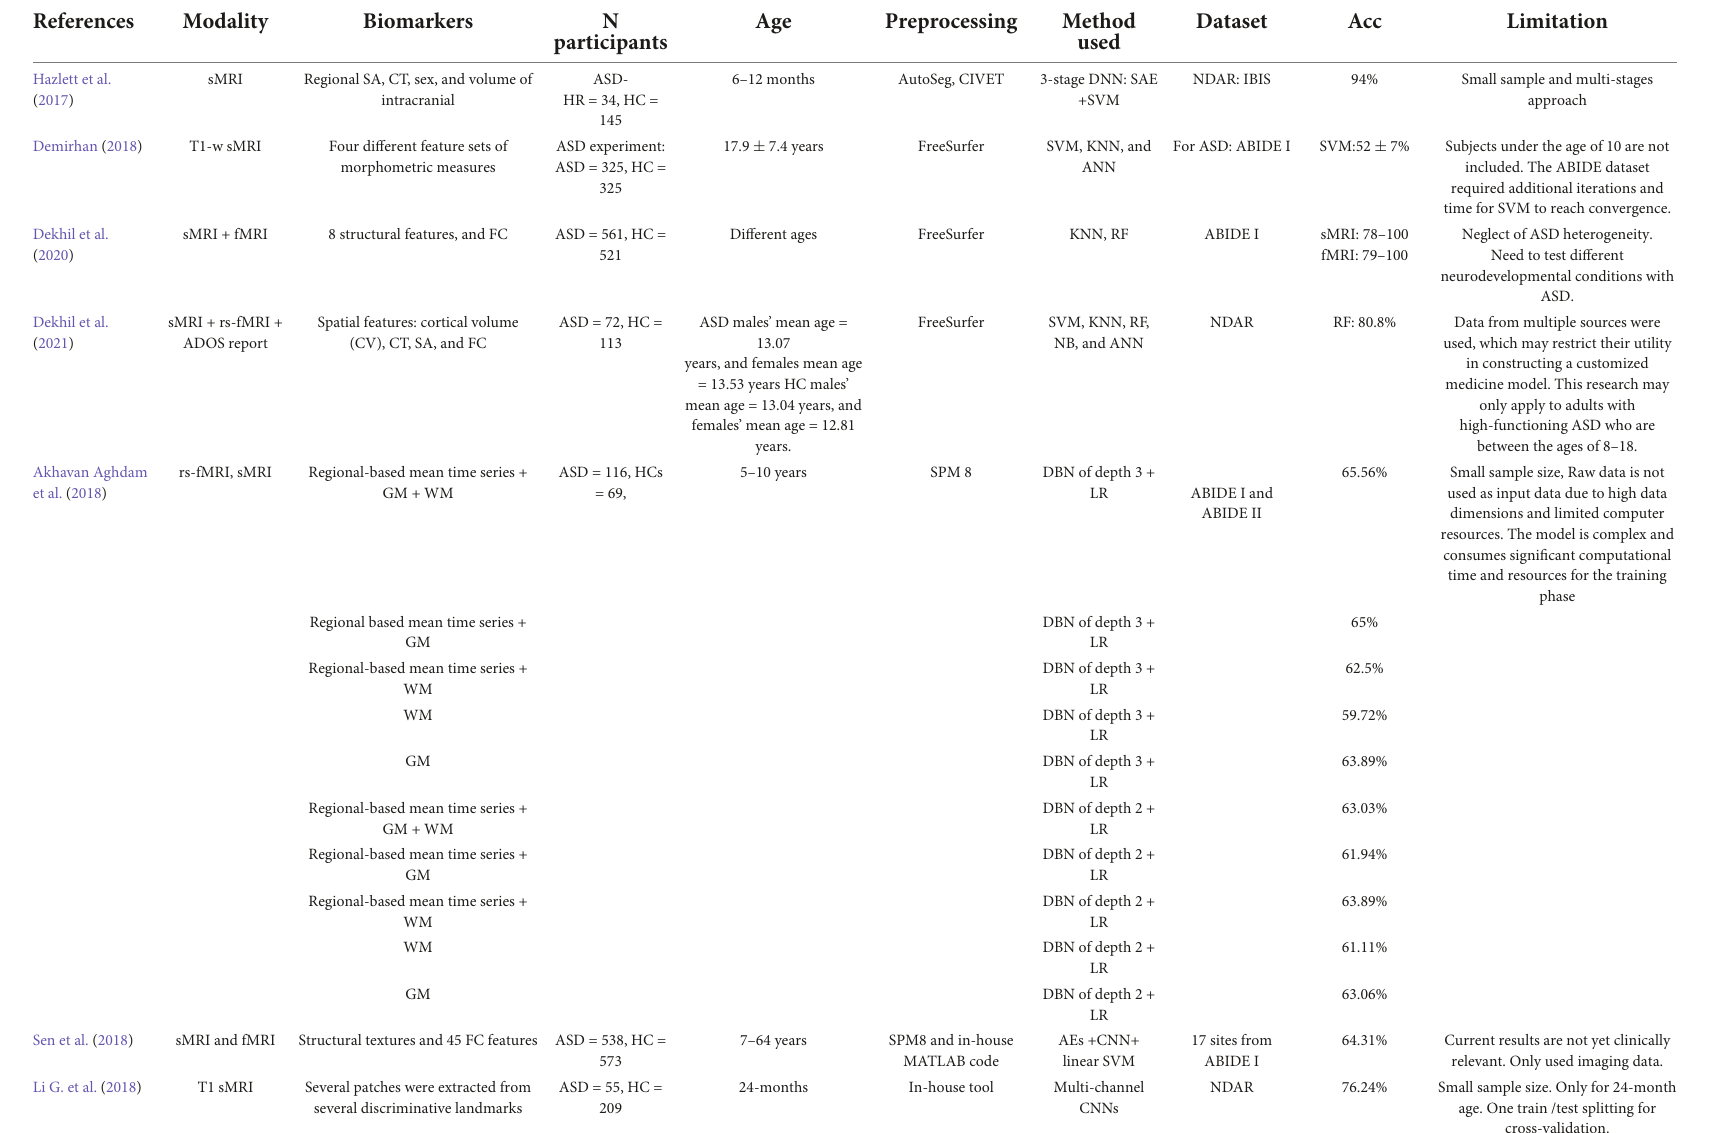
TABLE 3 Summary of 25 DL-based ASD classification